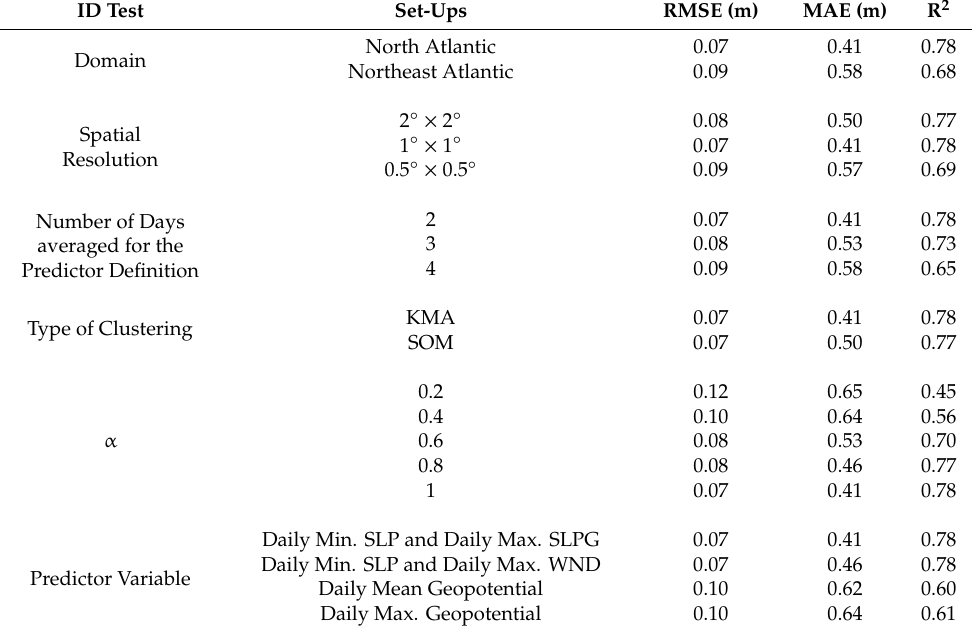
Table A1. Average errors of the set-up sensitivity tests for the years 2010 to